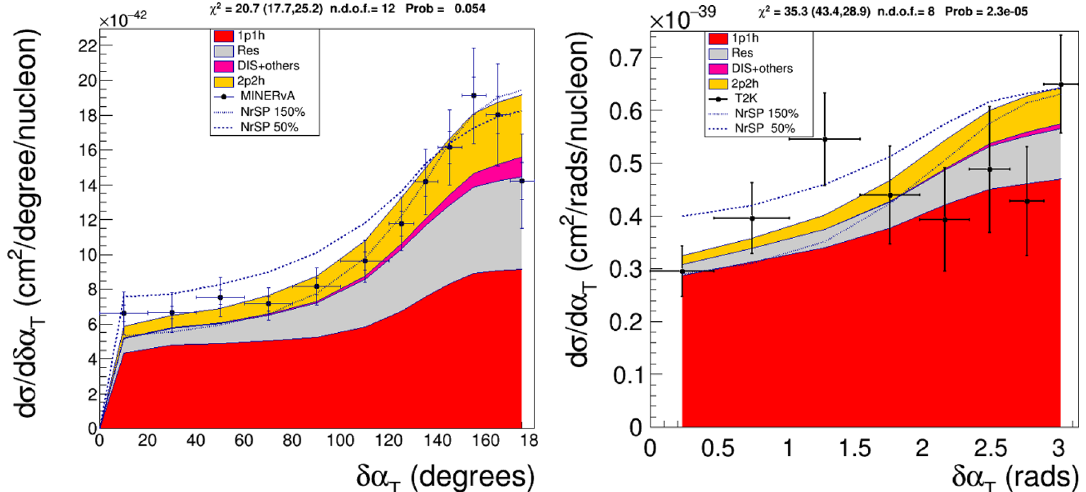
Figure 8 . CC 0 π 1 p MINERvA [15, 19, 20] (left) and T2K [21] (right) δα T distributions compared to the predictions of the implementation of NEUT in this work. The simulation has been done for three configurations of the NrSP (nominal, 50% and 150% strengths) and the obtained absolute χ 2 -values are compiled in tables 3 and 4.